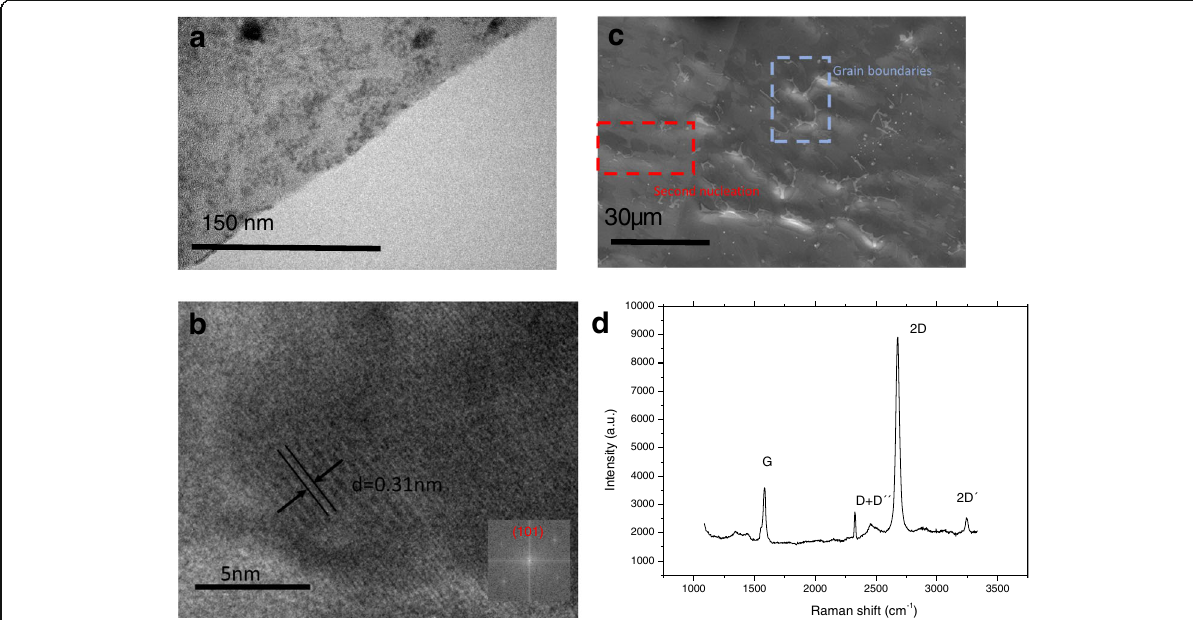
Fig. 2 Morphological and structural characterization. Detailed legend: a TEM image of Gr/WO3 film structure and Raman spectra. b HRTEM image of Gr/ WO3 and diffraction pattern of tungsten oxide corresponding to standard tetragonal (101) of WO3. c SEM image of the as-grown continuous graphene film. d Raman spectrum of the as-grown graphene film after transferring over